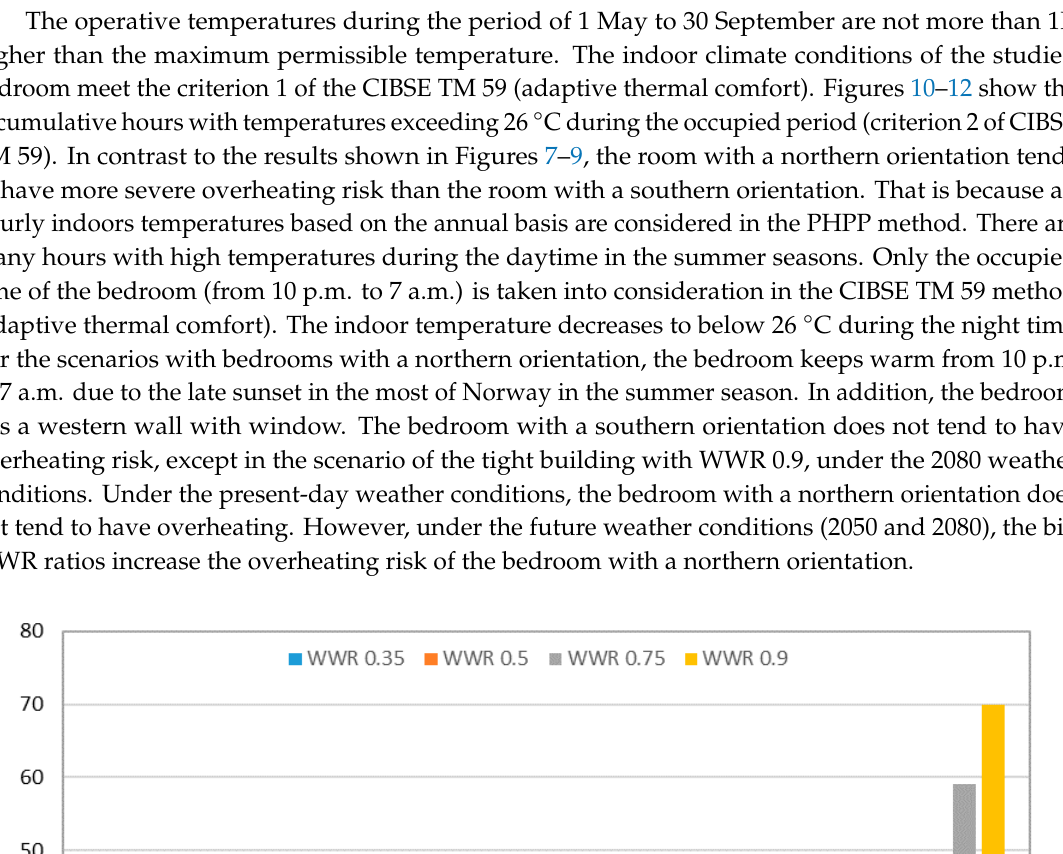
Figure 11. Hours of exceedance 26 °C during the occupied period based on CIBSE TM 59 (Average building).